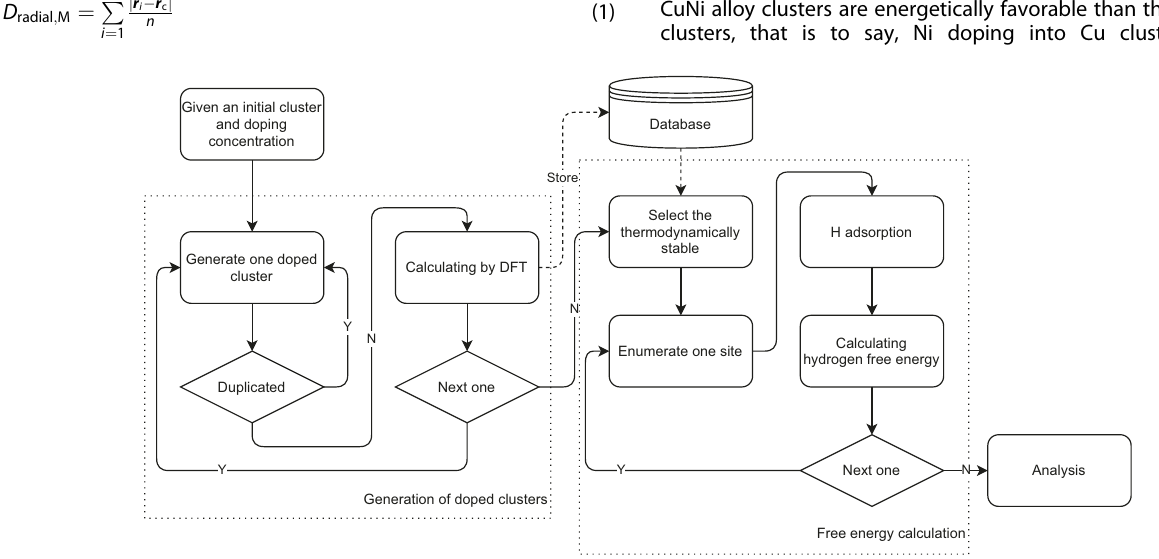
Fig. 1 Work fl ow of high-throughput screening. The work fl ow of computational high-throughput screening of HER electrocatalysts on metal alloy